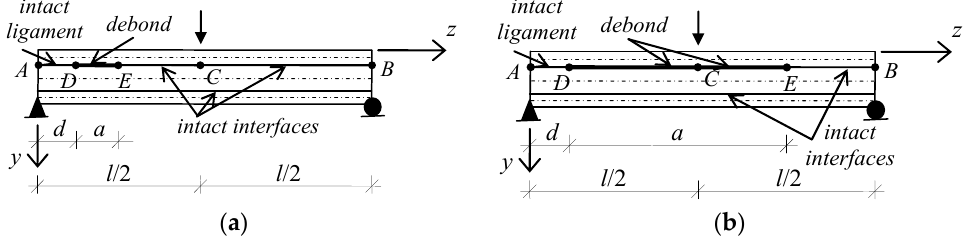
Figure 4. Simply supported composite sandwich beam case study: Upper interface generic configurations ( a ) for d + a ≤ l /2 and ( b ) for d + a > l /2.